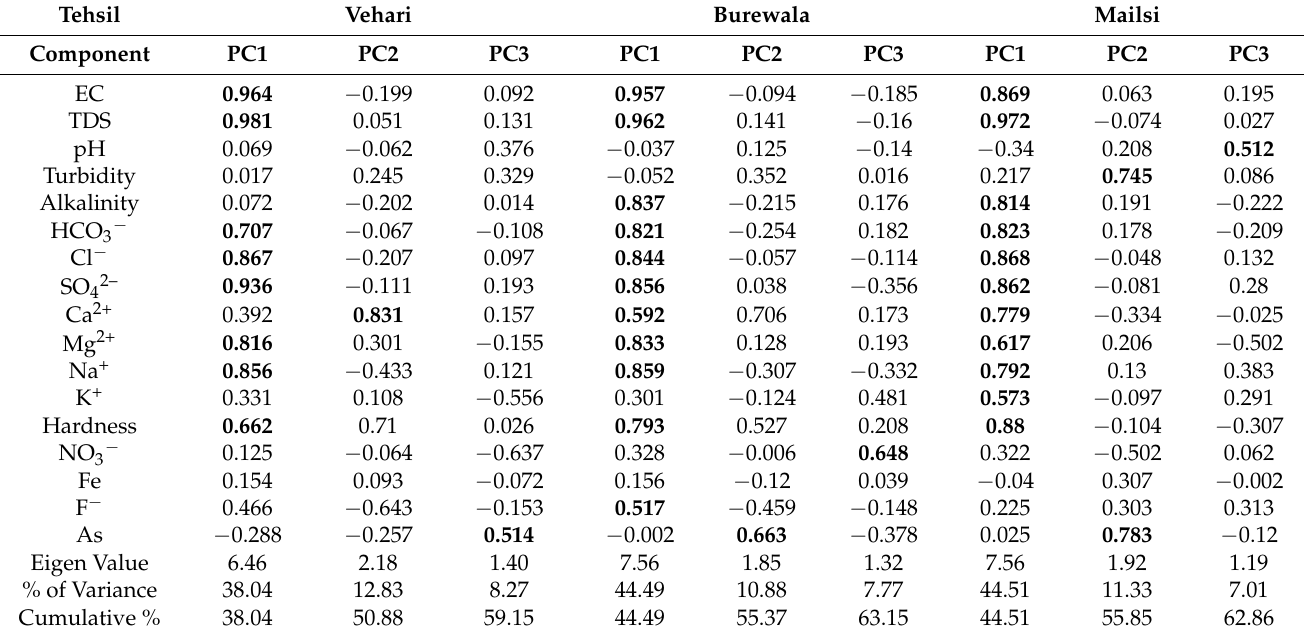
Table 2. Factor loading for groundwater physicochemical parameters in the study